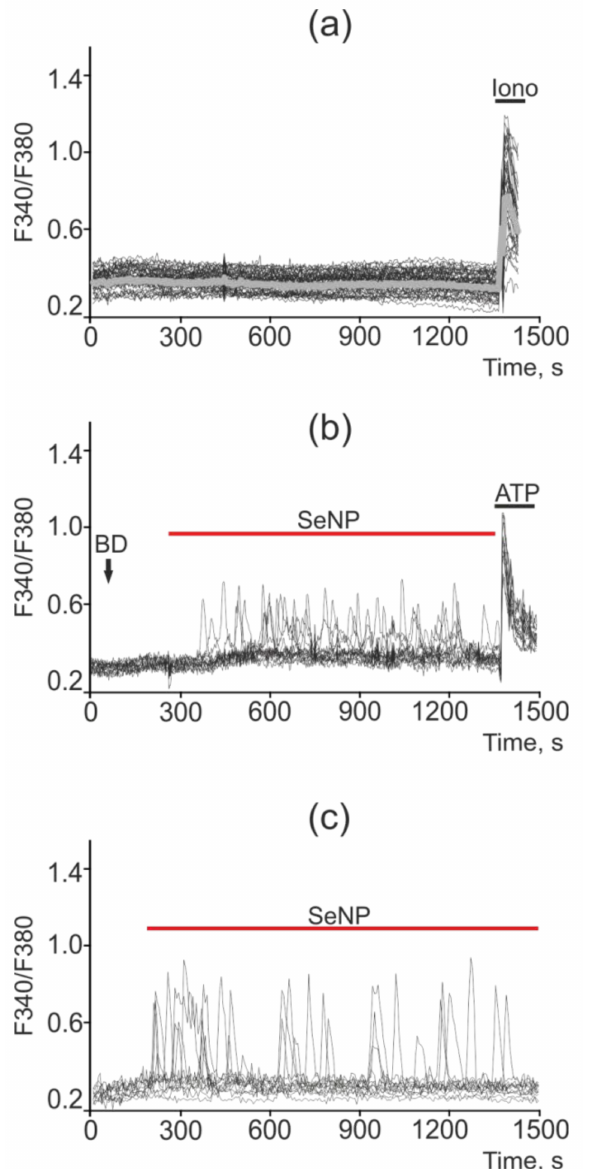
Figure 10. Ca 2+ signals in control A-172 cells ( a ) and in response to application of 0.5 µ g/mL ( b ) and 2.5 µ g/mL ( c ) SeNP. BD = application of bi-distilled water equivalent to the amount of SeNP solvent. At the end of the experiment, the Ca 2+ ionophore, Ionomycin (Iono, 1 µ M), or the purinoreceptor activator, ATP (10 µ M), was applied to normalize the [Ca 2+ ]i signal to the maximum. Typical Ca 2+ signals of cells are